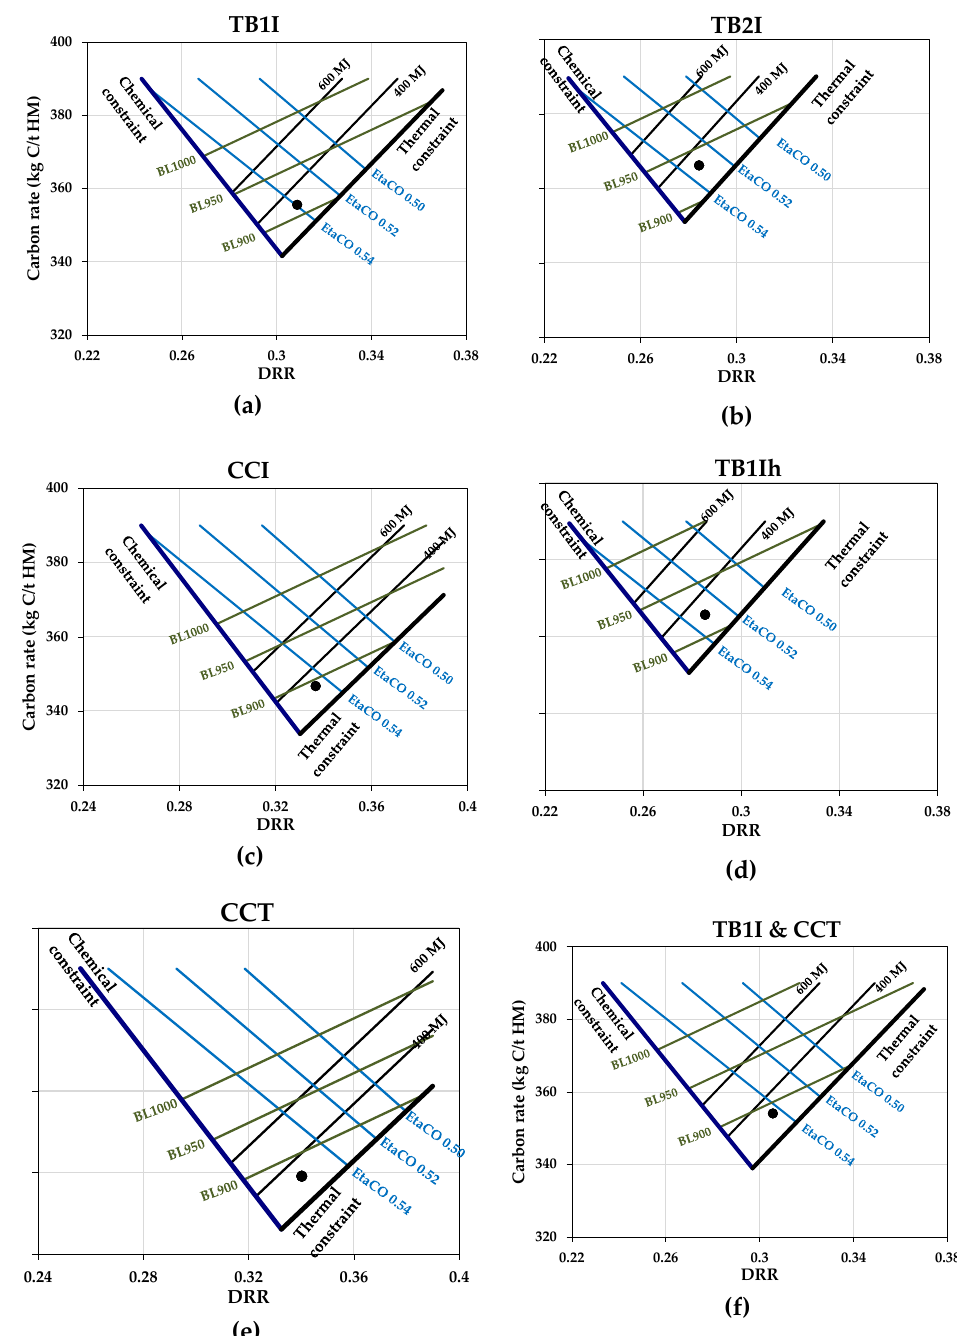
Figure 6. CDRR diagram of: ( a ) TB1I; ( b ) TB2I; ( c ) CCI; ( d ) TB1Ih; ( e ) CCT; ( f ) TB1I & CCT. Comparison of TB1I&CCT ((Figure 6f with Ref. (Figure 4) shows that TB1I&CCT correspond to a higher carbon rate (354 kg/tHM) and lower DRR (0.30), while the specific blast rate (892 Nm 3 /tHM) is slightly lower. The TB1I&CCT involves the introduction of in